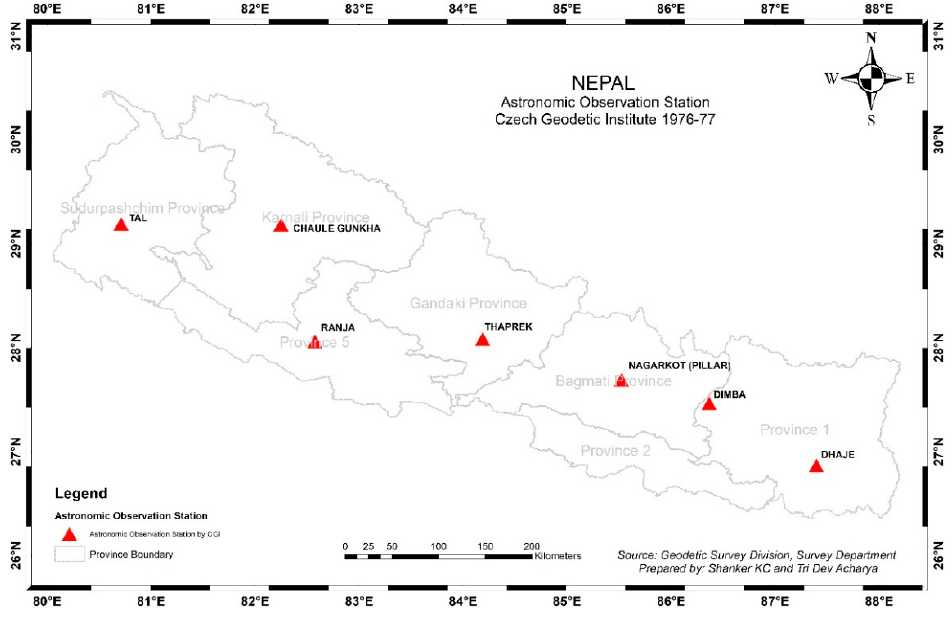
Figure 5. Astronomic observation stations in 1976–1977 by CGI. In 1975 − 1976, TSB measured length on 10 lines using a geodimeter. Geodimeter length measurements lines are shown in Figure 6.